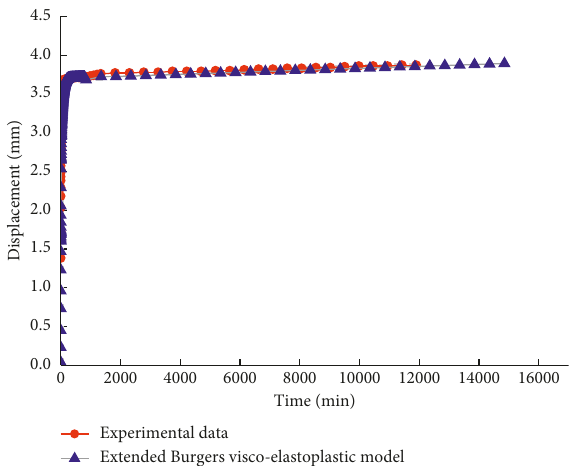
Figure 5: Comparison of theoretical and experimental values of the extended Burgers visco-elastoplastic model.